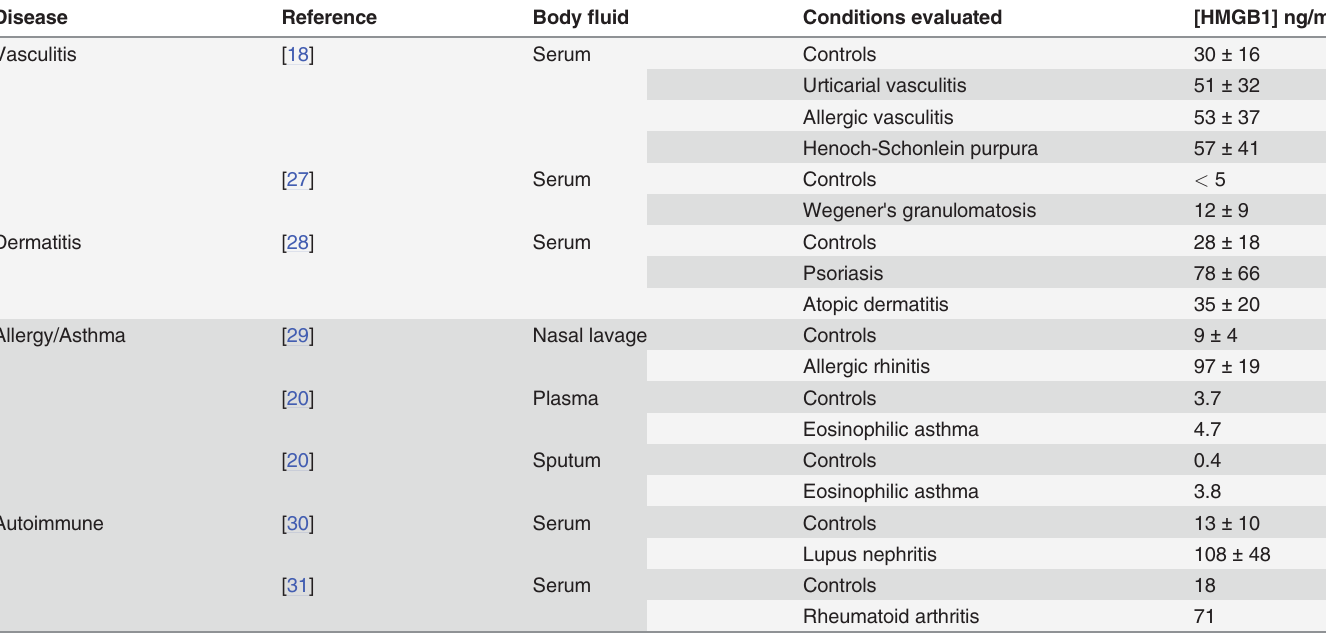
Table 1. HMGB1 concentrations associated with inflammatory and eosinophil-related diseases.